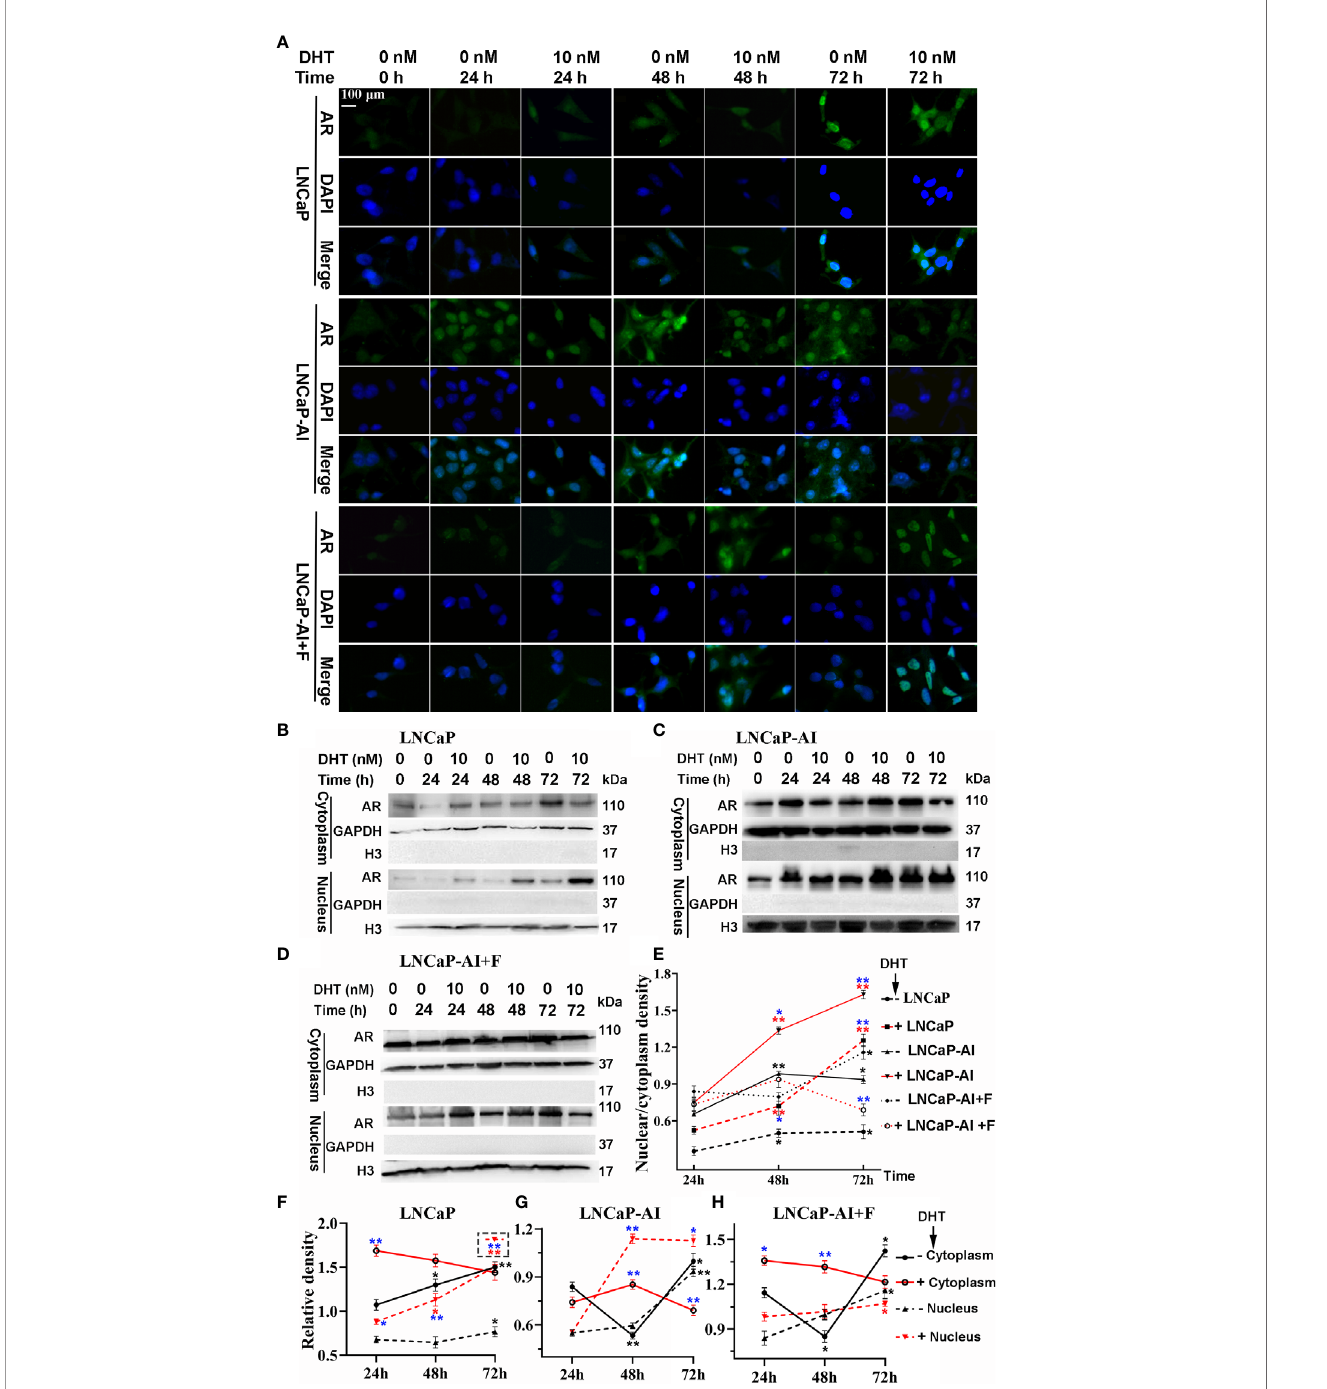
FIGURE 2 | LNCaP-AI cells exhibit higher nuclear translocation capability. (A – E) Three PCa cell lines were seeded for 24 h in FBS (LNCaP cells) or CS-FBS (LNCaP-AI cells) or CS-FBS added with 10 m M hydroxy fl utamide (LNCaP-AI+F cells), then treated with 10 nM DHT or equal amounts of ethanol and harvested 24 h, 48 h or 72 h latter. AR expression is observed by immuno fl uorescence (A) or WB (B – D) . (A) Cells were stained for AR (green), DAPI (blue). The scale bar in the upper left corner is 100 m m (40×). (B – D) AR cytoplasmic and nuclear extracts are shown in LNCaP, LNCaP-AI and LNCaP-AI+F cells, respectively. (E – H) The AR density of each band in (B – D) was analyzed by ImageJ 1.52i software (National Institutes of Health, USA). AR levels in each cell line were normalized to GAPDH (cytoplasm) or H3 (nucleus) and shown in (F – H) as well as AR nucleus/cytoplasm ratios shown in (E) . The results are expressed as the mean ± S.D. of three biological replicates.One-way ANOVA followed by Dunnett ’ s test for different time points compared with 24 h treated with DHT (*P < 0.05, **P < 0.01) or alcohol (*P < 0.05, **P < 0.01) (n = 2) and T test for the same cell line treated with alcohol or 10 nM DHT (*P < 0.05 , **P <